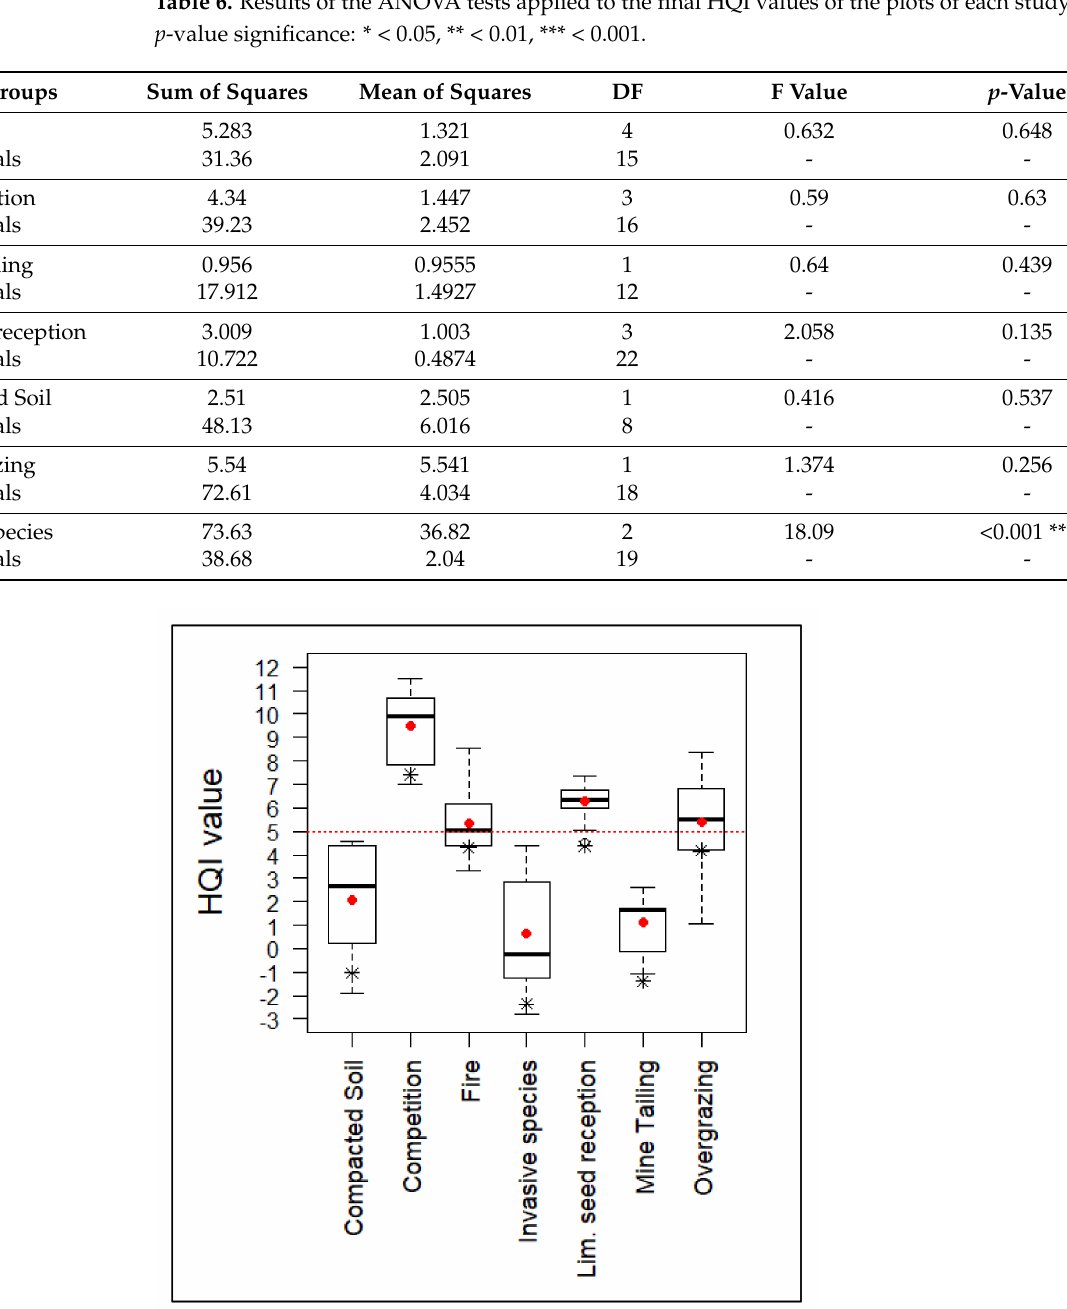
Table 6. Results of the ANOVA tests applied to the final HQI values of the plots of each study group.